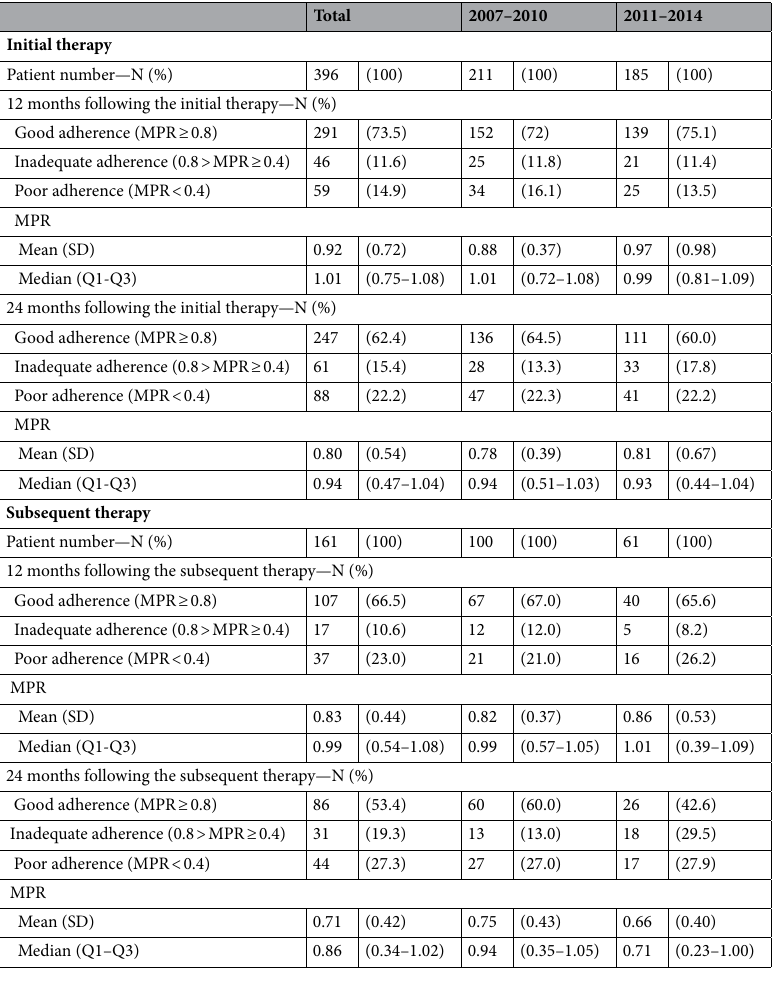
Table 4. Adherence of initial therapy and subsequent therapy.